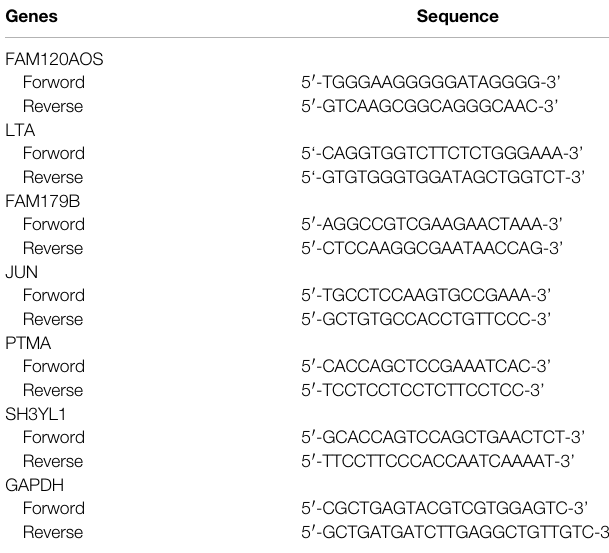
TABLE 1 | The relationship in the miRNA-mRNA-TF regulatory network. Genes